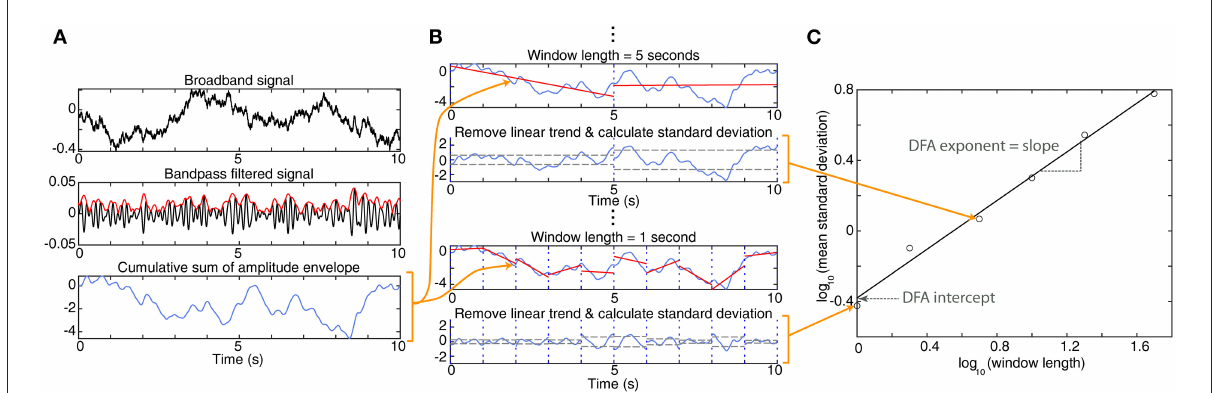
FIGURE5 Detrended fluctuation analysis. (A) To start, the broadband EEG signal (top panel) is bandpass filtered (black line, middle panel), and the amplitude envelope is determined (red line). Then the cumulative sum of the amplitude envelope is calculated (bottom panel). The remaining calculations use this cumulative sum. (B) The cumulative sum is divided into windows of a fixed length; typically, these windows overlap by 50%, but no overlap is shown in this figure for clarity. Within each window, a linear trend is fit to the data (red line). Then, for each window, the linear trend is subtracted, and the standard deviation of the residual is calculated (gray dashed line). This process is repeated for windows of varying lengths. Here, we show examples of 5-s and 1-s windows. (C) For each window length, the mean standard deviation across all windows is calculated. This is plotted on a logarithmic scale vs. the window length. For EEG data, this will typically result in data points with a linear relationship. A linear trend line is fit to the data points on this graph; the slope of the line is the DFA exponent, and its intersection with the vertical axis is the DFA